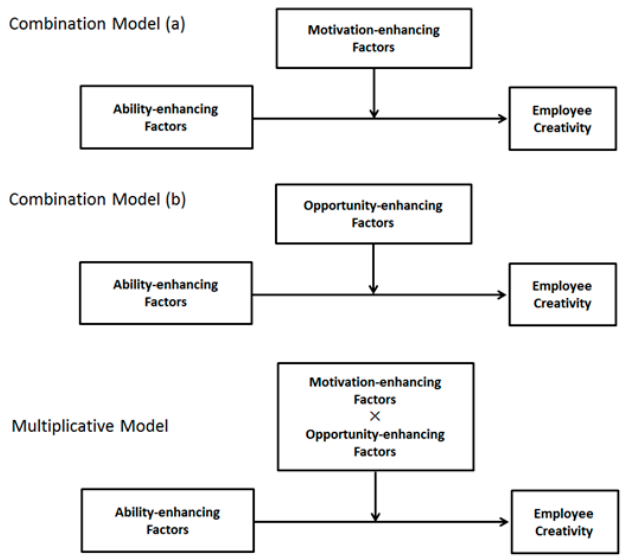
Figure 2. Combination and multiplicative models.